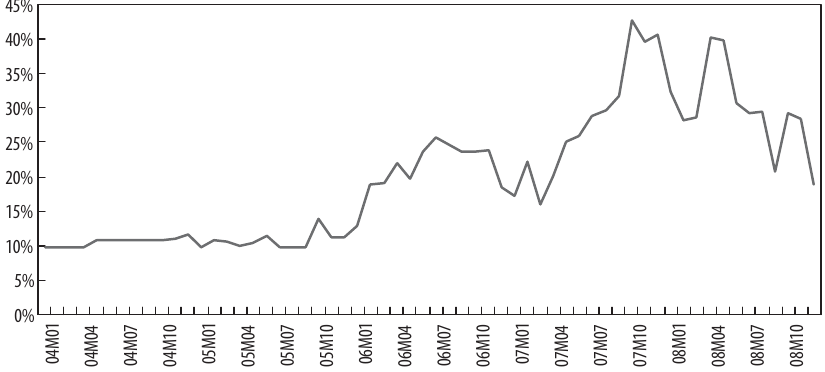
Figure 5. Trend of bubble price deduced from